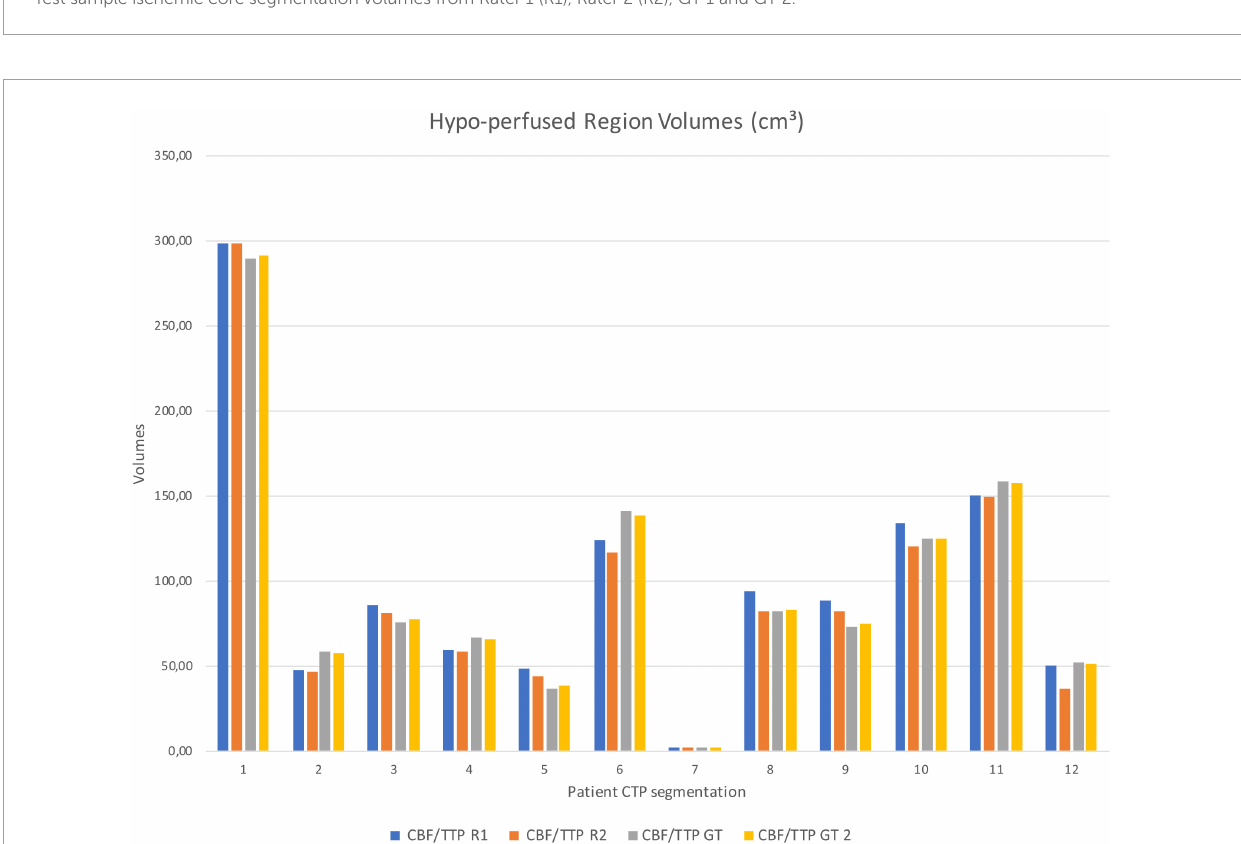
FIGURE6 Test sample CBF/TTP segmentation volumes from Rater 1 (R1), Rater 2 (R2), GT 1 and GT